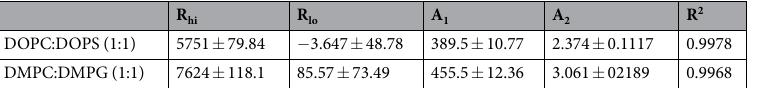
Table 1. Surface plasmon resonance fitting